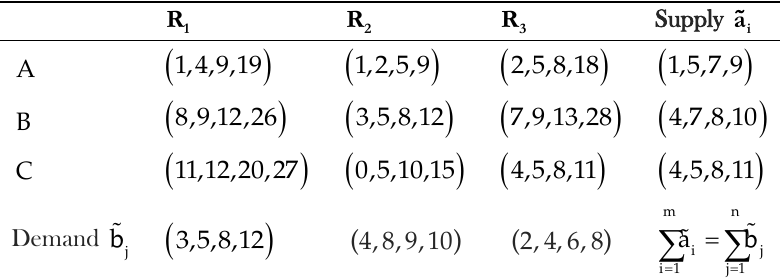
Table 2. Eq. (15) in trapezoidal balanced